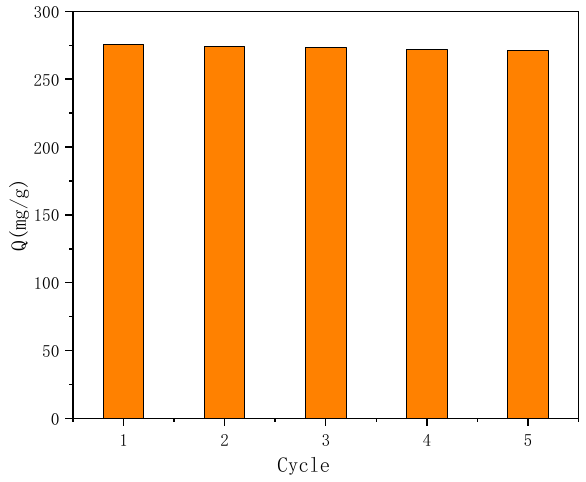
Figure 11. Reusability of γ -Fe 2 O 3 @GMA@IM adsorption FCF.